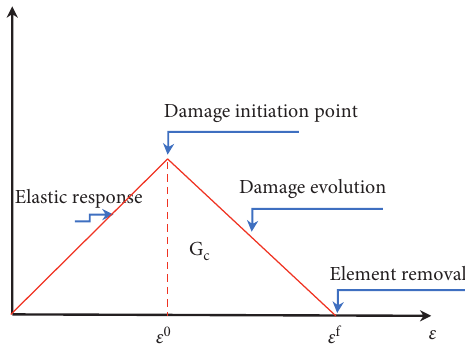
Figure 7: Damage response of CFRP Table 1: Material properties of unidirectional fiber reinforced sheet [15].